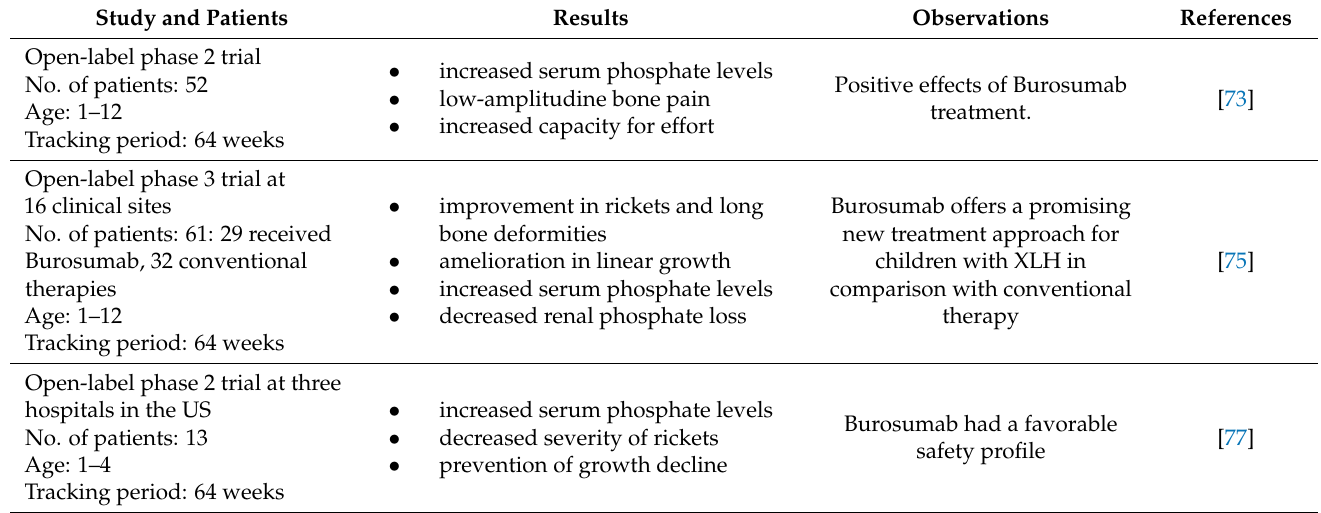
Table 5. Open-label studies and multiple case reports about the effects of the Burosumab